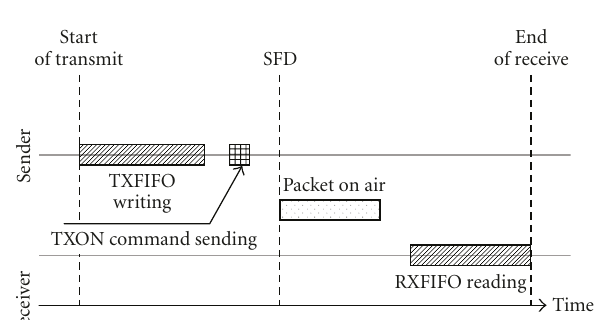
Figure 22: Link quality versus time.